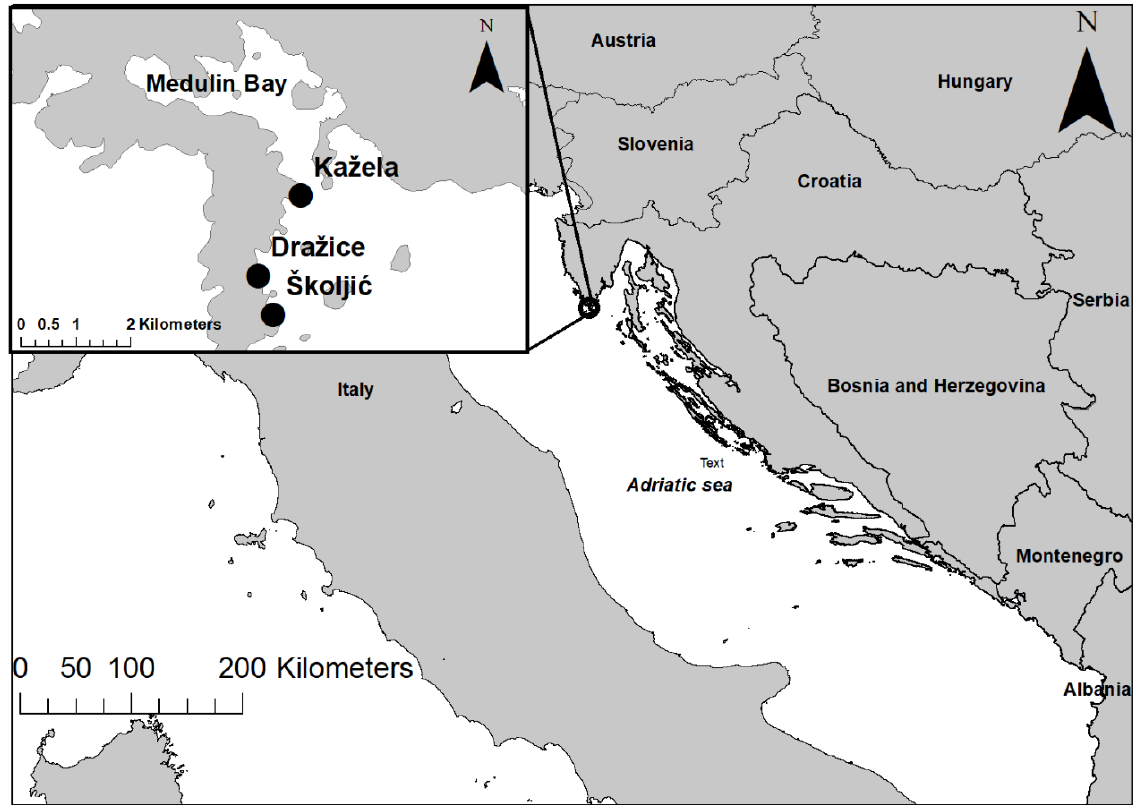
Figure 1. Sampling locations in the Bay of Medulin.